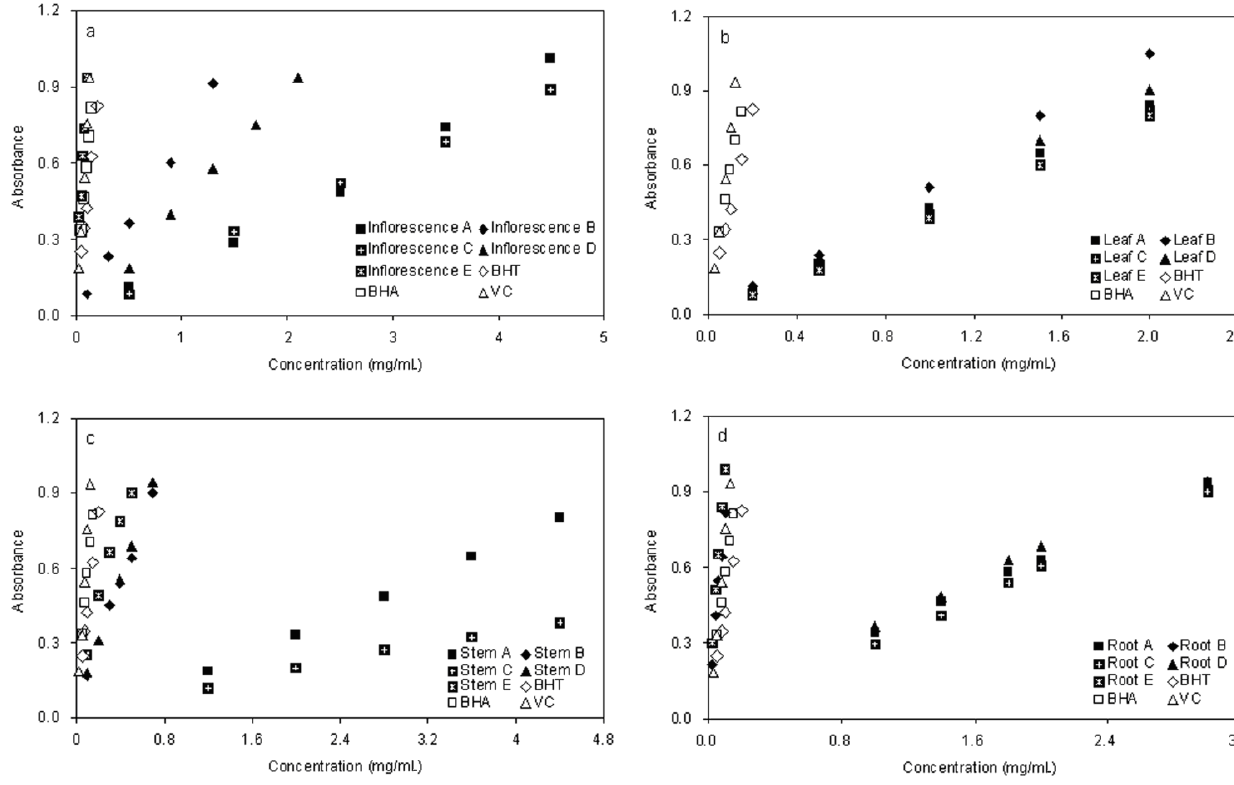
Figure 4. Reducing Power for Fractions of Different Parts of E. ciliata .